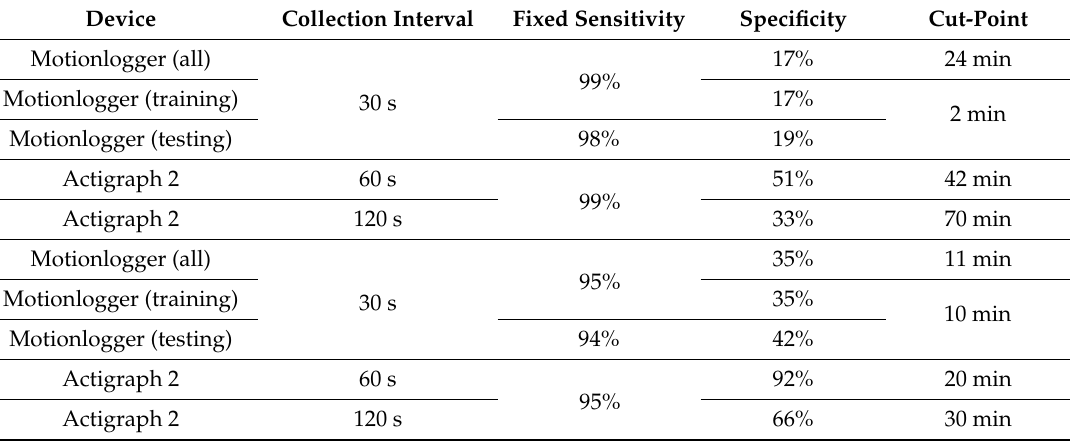
Table 2. Optimizing inclusion of inactive data and impact on o ff -wrist detection. Device Collection Interval Fixed Sensitivity Specificity